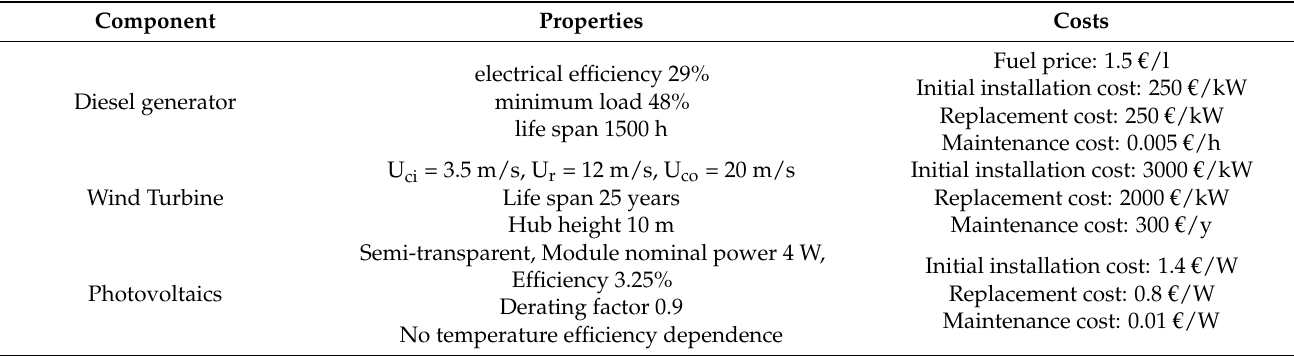
Table 4. Hybrid system basic